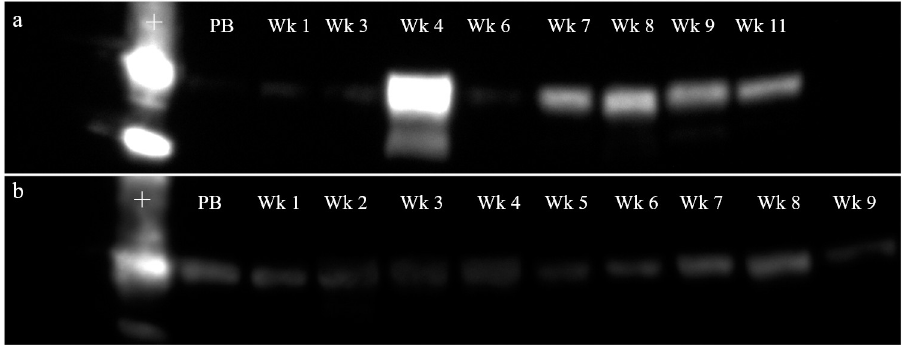
Fig 5. Comparison of pregnant and non-pregnant luteal phase in the cheetah. (a) IgJ was increased in week 4 and following week 7 post-breeding during pregnancy (Female #6592). Insufficient fecal samples were collected for weeks 2 and 5, so no information on IgJ abundance is available for those weeks. (b) IgJ remained at or near pre-breeding levels throughout the 9 week sample period during a non-pregnant luteal phase (Female #6339). Positive Control is denoted by “+.” Pre-breeding sample is denoted by